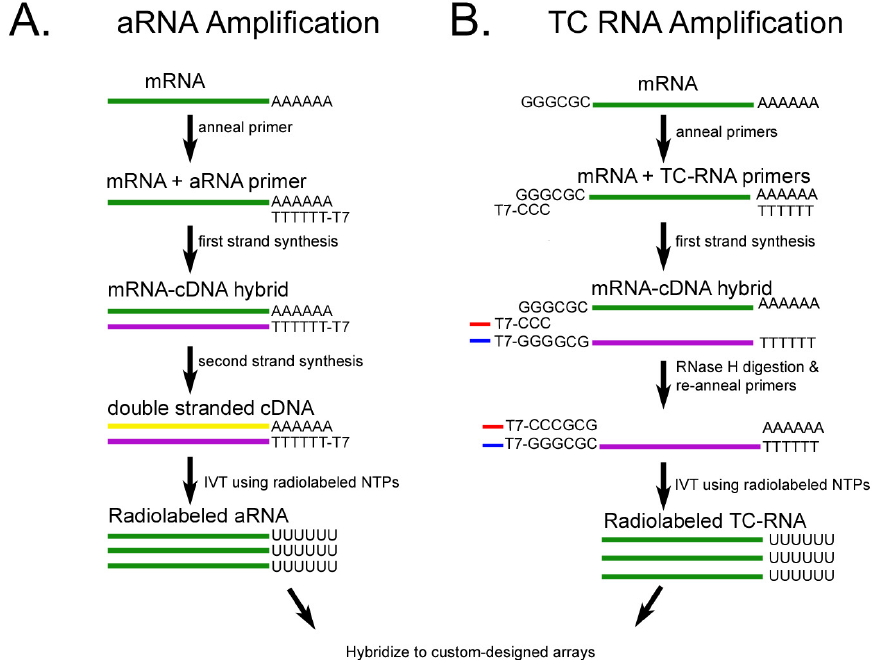
Figure 1. Schematic representation of the aRNA (left panel) and TC RNA amplification (right panel) methods as they are applied to custom-designed cDNA array